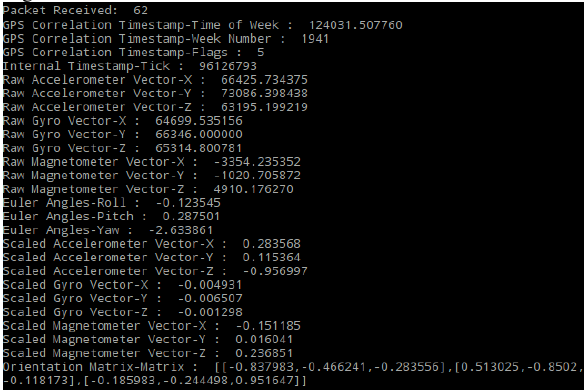
Figure 3. Data Packet of inertial sensors with python app on RPi